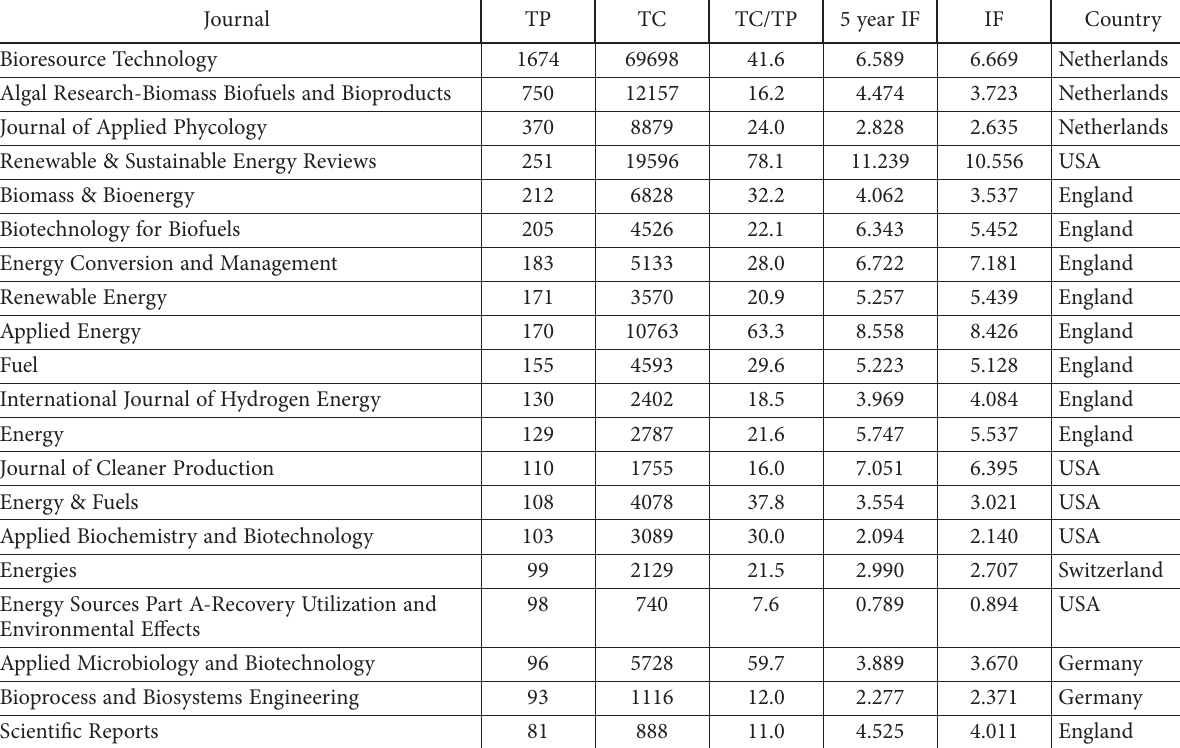
Figure 3. The publications distribution of the top 20 most productive subject categories Table 1. The top 20 most productive